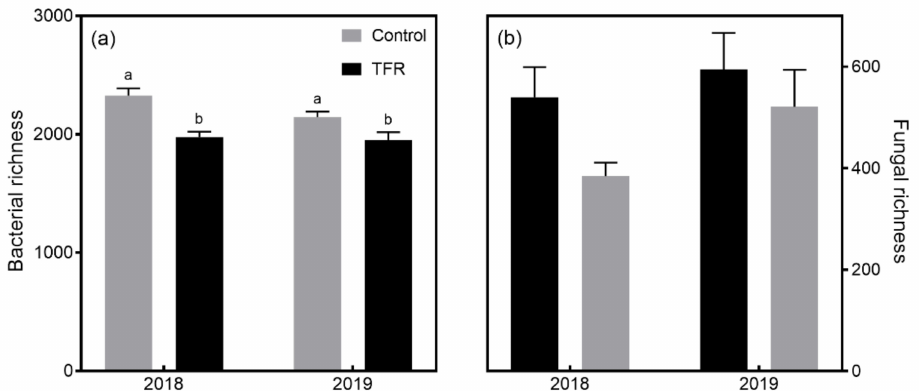
Figure 1. ( a ) Bacterial richness and ( b ) fungal richness under different treatments in 2018 and 2019. Operational taxonomic unit (OTU) richness is represented by the Sobs index; Control, ambient precipitation; TFR, throughfall reduction. Different letters indicate significant differences ( p < 0.05).